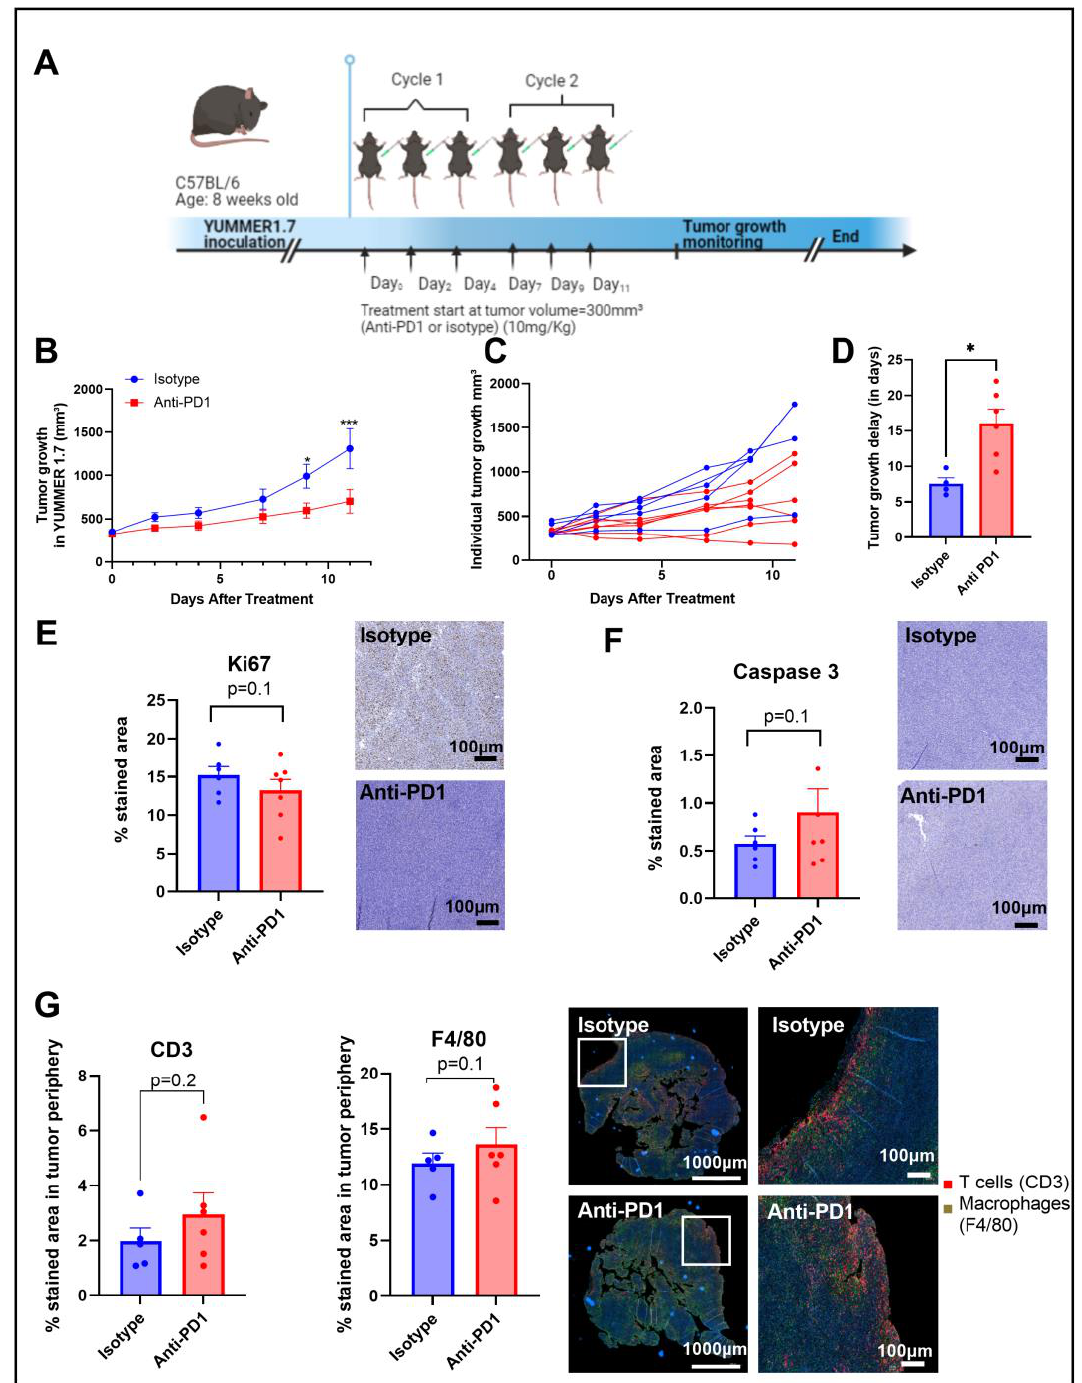
Figure 1. Timeline of the in vivo protocol ( A ). Tumor growth curve, individual tumor growth, and corresponding calculated growth delay as the time (in days) to reach a volume of 1000 mm³ in YUMMER1.7 melanoma xenografts ( B – D ). IHC staining for Ki67 and caspase 3 after 2 cycles of IT ( E , F ); sample size n = 5–7/group. Illustrations and quantification of T cell (CD3-red) and macrophage (F4/80-green) expressions evaluated by multiplex immunofluorescence (IF) in melanoma tumors after 2 cycles of IT (total tumor area and the tumor periphery area) ( G ). *: p ≤ 0.05; the dots correspond to the data points; *** p ≤